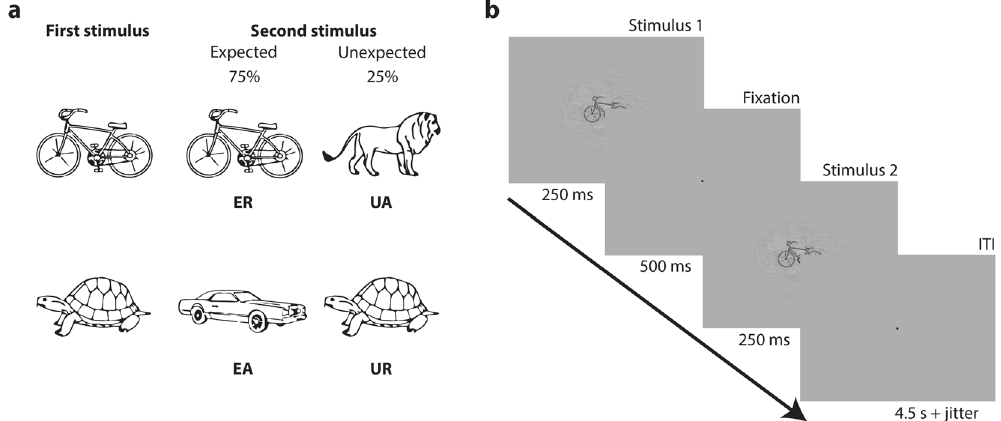
Figure 1. Paradigm and task. (a) Examples of fixed stimulus pairings. Participants learned that some stimuli are most likely to repeat, whereas others are most likely to alternate, thus creating expected repetitions (ER) and expected alternations (EA), as well as unexpected repetitions (UR) and unexpected alternations (UA). (b) Stimulus display, here showing an expected repetition (ER) trial. In the behavioral discrimination task, participants responded to the category of the second stimulus (vehicle or animal) during the inter-trial interval (ITI). During the fMRI oddball task, participants responded to occasional oddball targets (17.4% of trials) in which the stimulus was shown at 60% of its normal